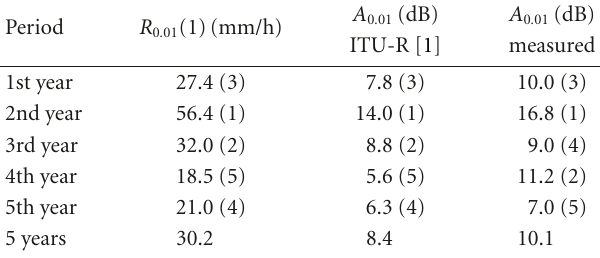
Table 1: Comparison of the measured rainfall intensities, the cal- culated attenuation due to rain, and the measured attenuation due to rain for the individual-year periods and the entire 5-year period for 0.01% of time of year only. Note that the numbers in parenthesis are the span of relevant quantities from the highest value to the lowest one